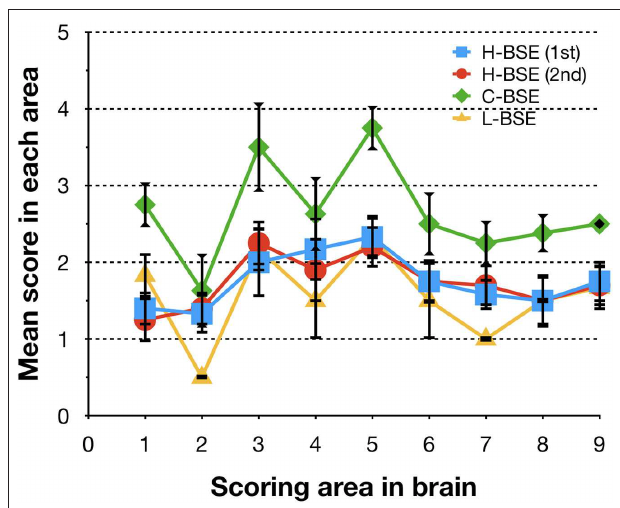
FIGURE 4 | Comparison of lesion profiles of hamsters infected with three different BSE strains. Lesion profiles of hamsters inoculated with H-BSE prion passaged in TgHaNSE mice (first passage, blue square; second passage, red circle), Mouse-adapted C-BSE prion passaged in TgHaNSE mice (green diamond), and L-BSE prion from cattle (yellow triangle). Vacuolation was scored on a scale of 0–5 in the following brain areas: 1, dorsal medulla; 2, cerebellum; 3, midbrain; 4, hypothalamus; 5, thalamus; 6, hippocampus; 7, septal nuclei of the paraterminal body; 8 caudal cerebral cortex; and 9, rostral cerebral cortex. Data represent mean ± standard deviation ( n = 4–6). The vacuolar lesion scores for C-BSE and L-BSE were taken from a previous study (10).